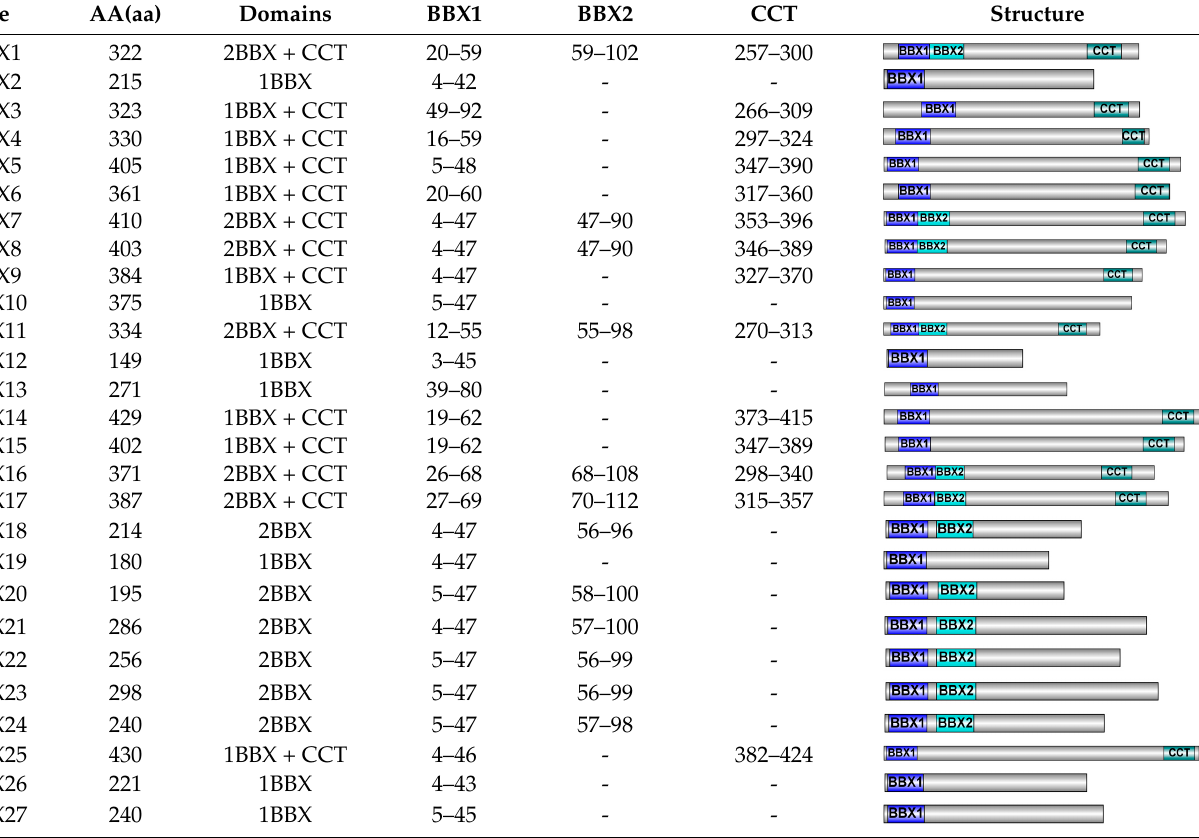
Table 2. SmBBXs protein structures.